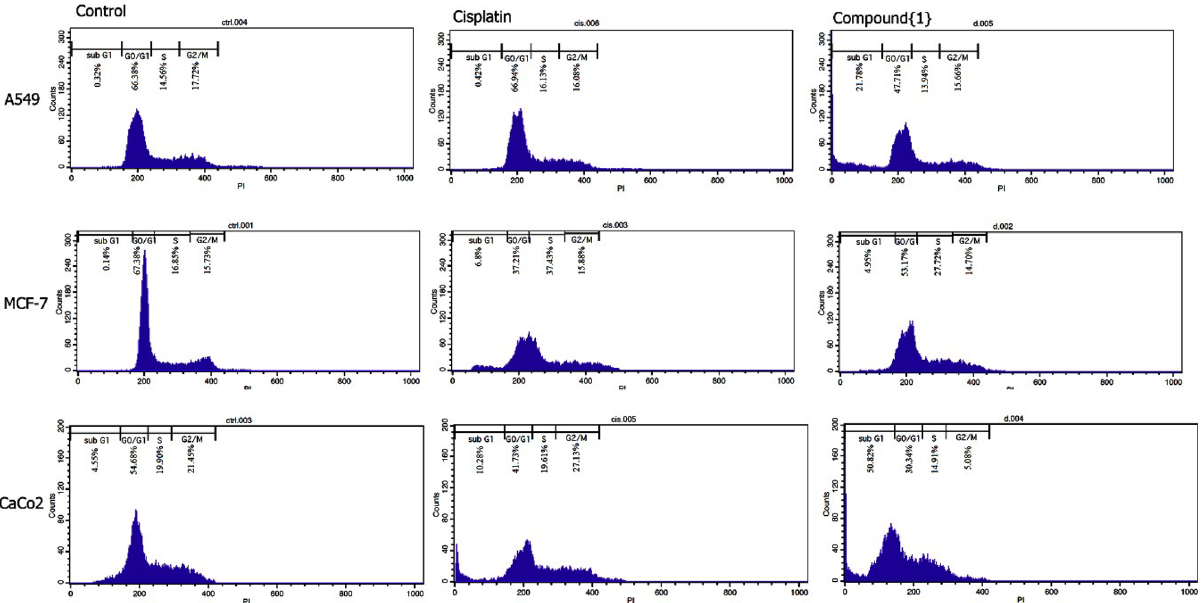
Figure 3. Cell cycle distribution of MCF-7, A549 and Caco-2 cells treated with the indicated IC 50 concentrations of Pt(TSC)Cl complex (compound{1}) and cisplatin for 48 h determined by staining the DNA content of the cell followed by flow cytometry. The percentage of cells in G0/G1, S or G2/M phase is indicated. A549